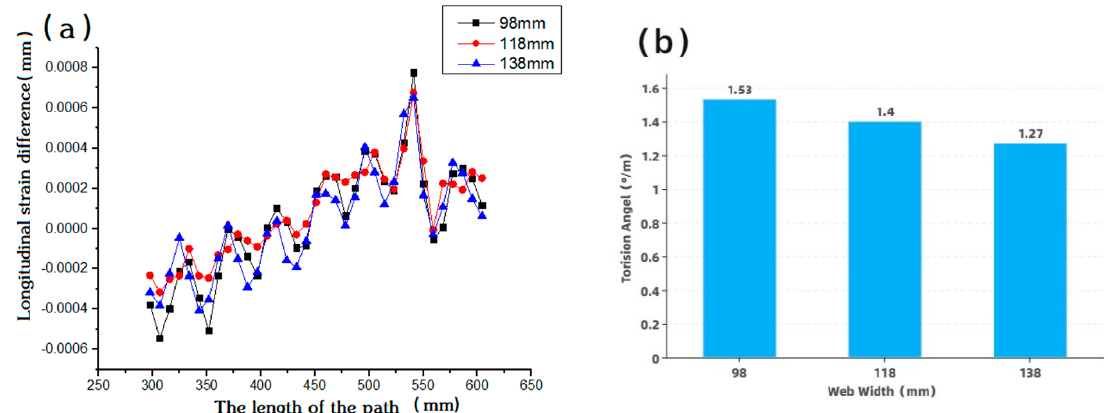
Figure 8. Simulation results of different web widths. ( a ) Influence of different web width on torsion; ( b) Torsion decrease about 0.13°/m with an average 20 mm increase in flange width.